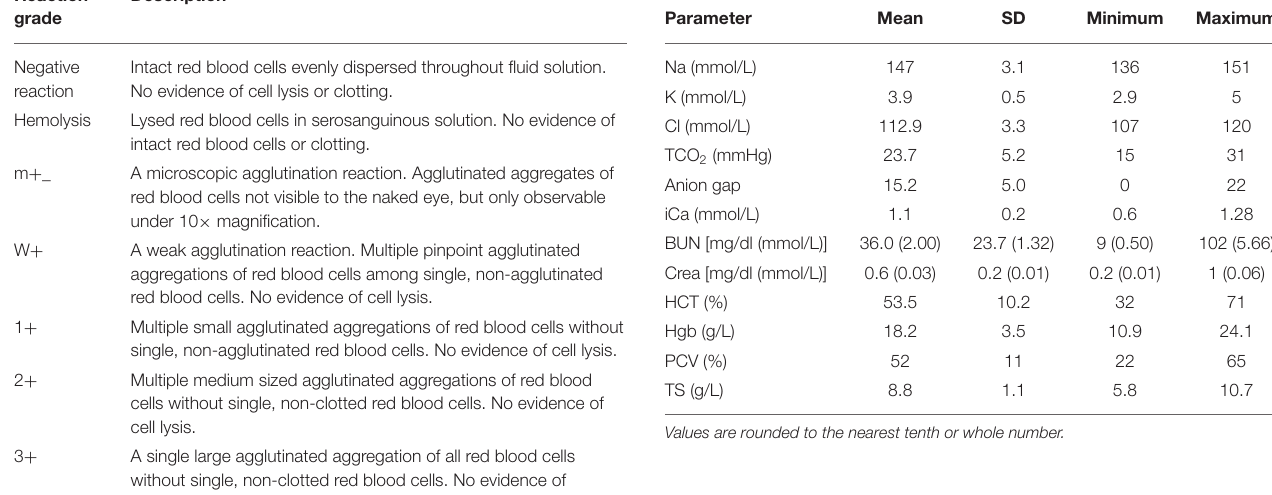
TABLE 1 | Description of microscopic and macroscopic transfusion reactions. Reaction Description grade